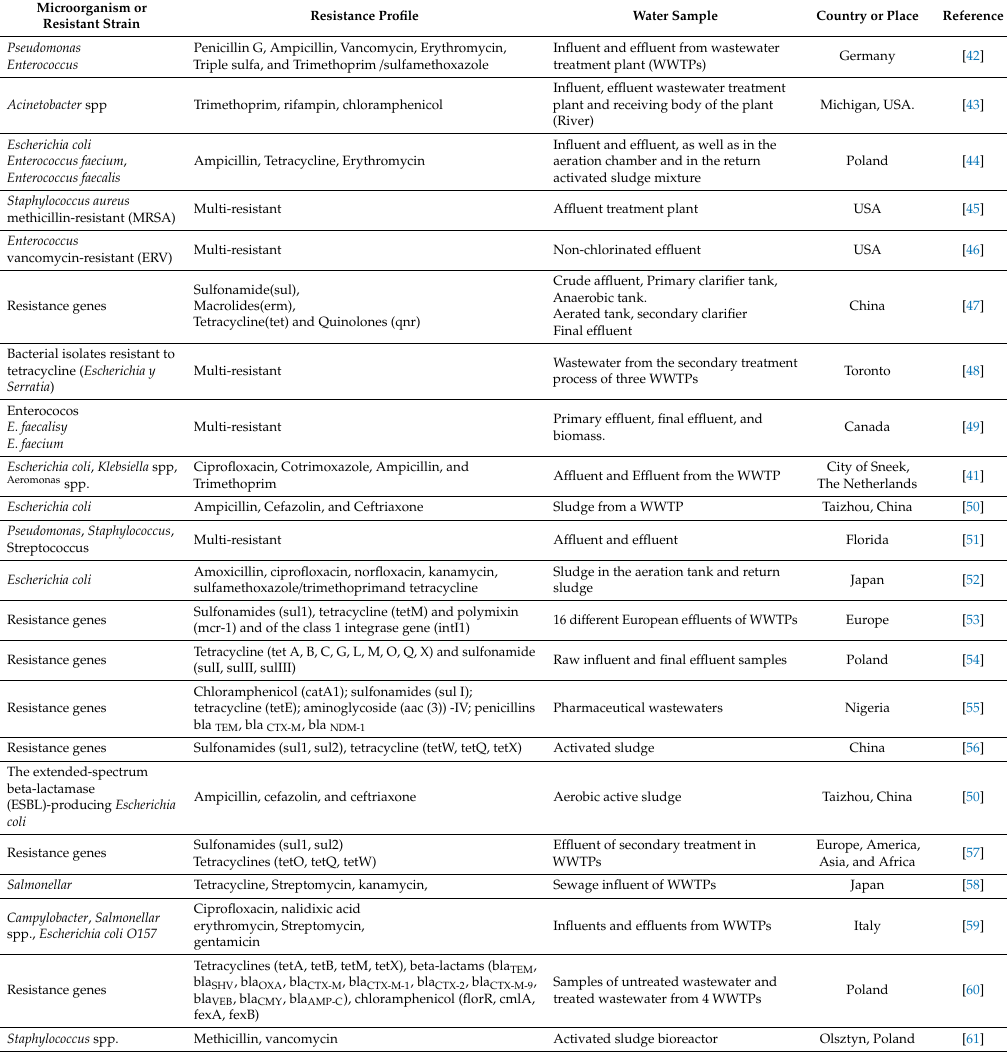
Table 1. Examples of microorganisms found in di ff erent wastewater treatment